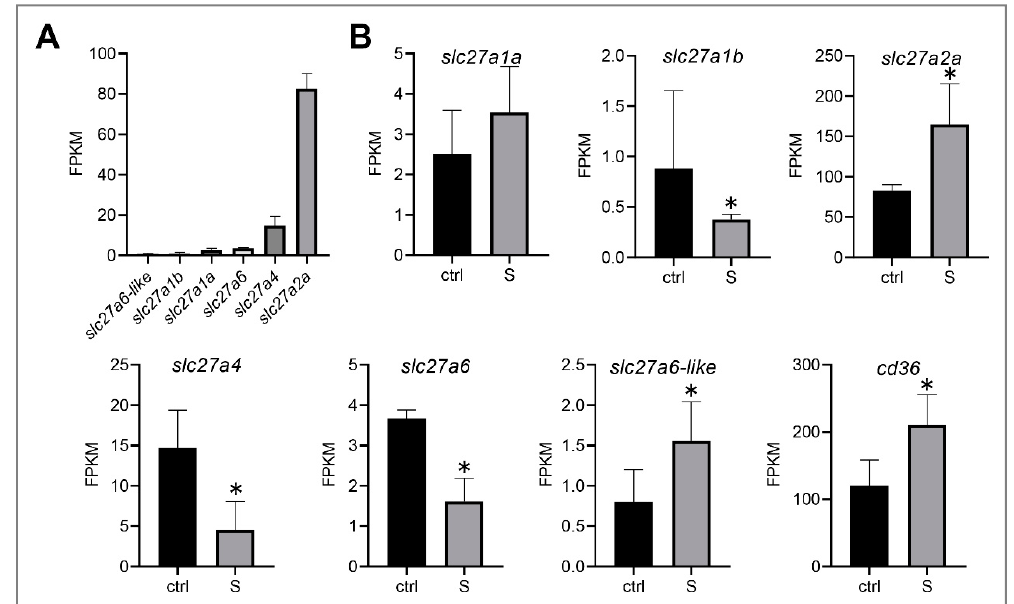
Figure 3. Effect of starvation on the gene expression involved in the transmembrane transport of fatty acids in liver tissues. ( A ) Gene expression of solute carrier family 27 (fatty acid transporter), including slc27a1a , slc27a1b , slc27a2a , slc27a4 , slc27a6 , and slc27a6-like , were extracted in the control larvae from the RNA-seq data. ( B ) Differential expression of fatty acid transporter and fatty acid translocase ( cd36 ) in the control and starved larvae. The FPKM (Fragments Per Kilobases Per Millionreads) value represents the mean ± SEM of three independent RNA-seq biological replicates. * indicates significant differences ( p < 0.05).